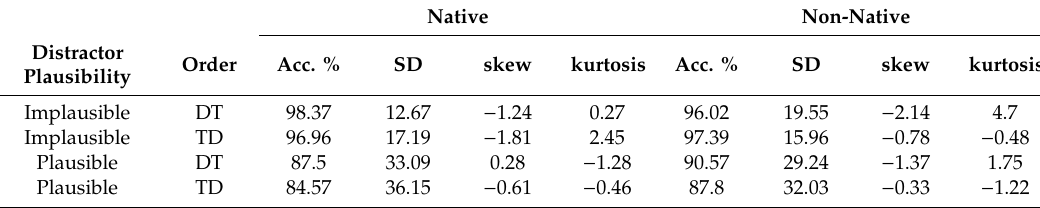
Table A4. Additional data for accuracy in selection of the target verb by